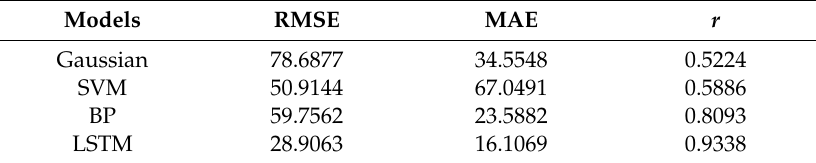
Table 2. The predictive performance of four di ff erent models on the testing